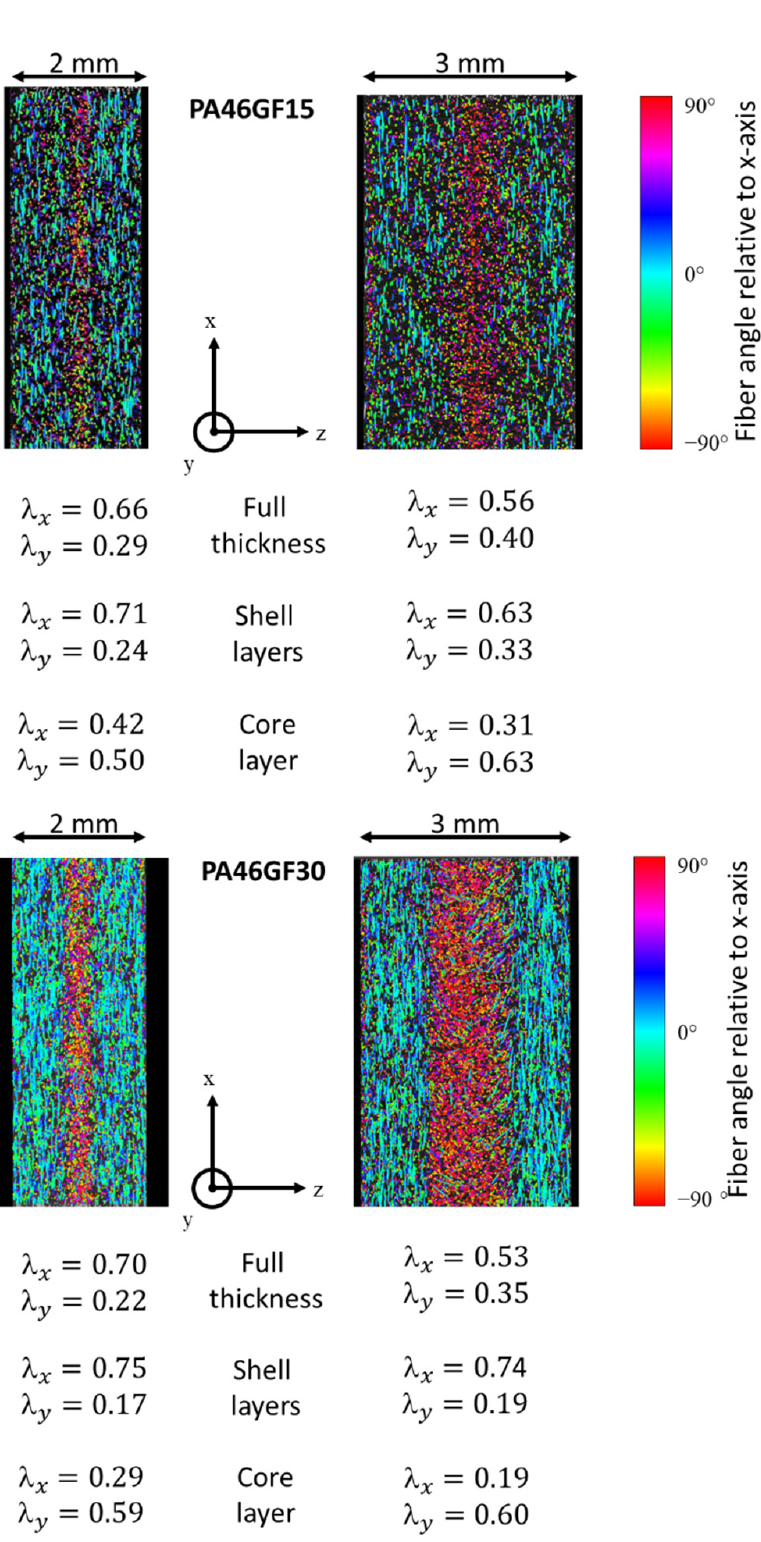
Figure 3. µ CT-scans of 2 mm specimens ( left ) and 3 mm specimens ( right ) with a 15% fiber fraction ( top ) and 30% fiber fraction ( bottom ) and determined eigenvalues of the fiber orientation tensors.